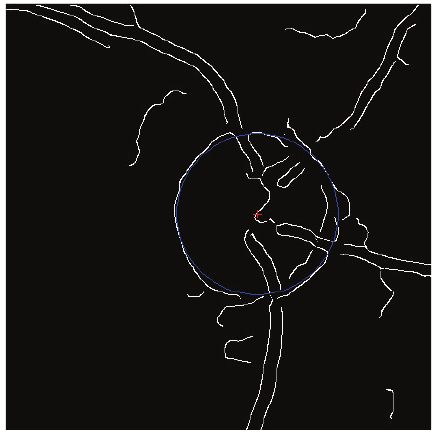
Figure 3: Result of circle Hough transform. The blue line is the esti- mated disc